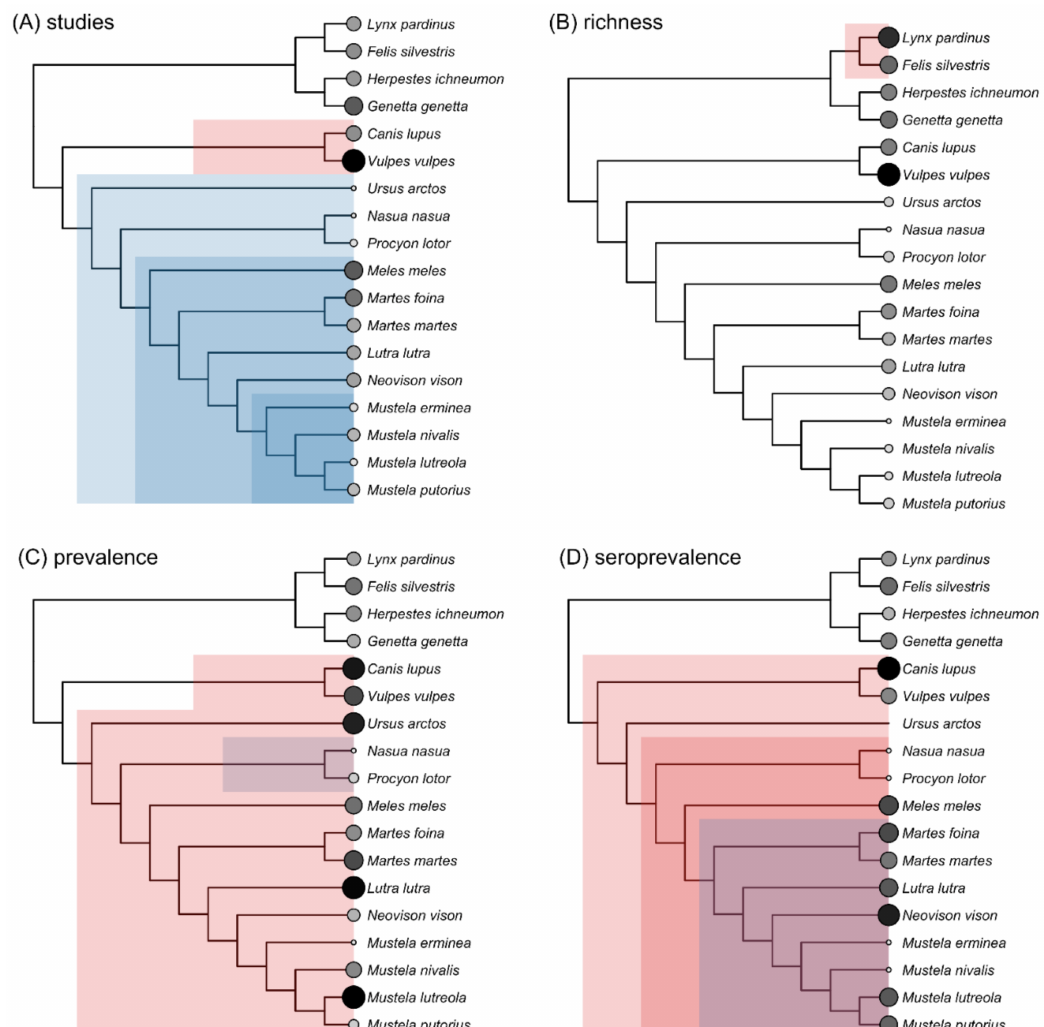
Figure 5. Taxonomic patterns in sampling effort ( A ); pathogen richness, after adjusting for sampling effort ( B ); total infection prevalence ( C ); and total seroprevalence ( D ) across the Iberian carnivore phylogeny. Points are scaled and colored by each response variable. Shading denotes carnivore clades with greater (red) or lesser (blue) of each response variable compared to the paraphyletic remainder as identified by phylogenetic